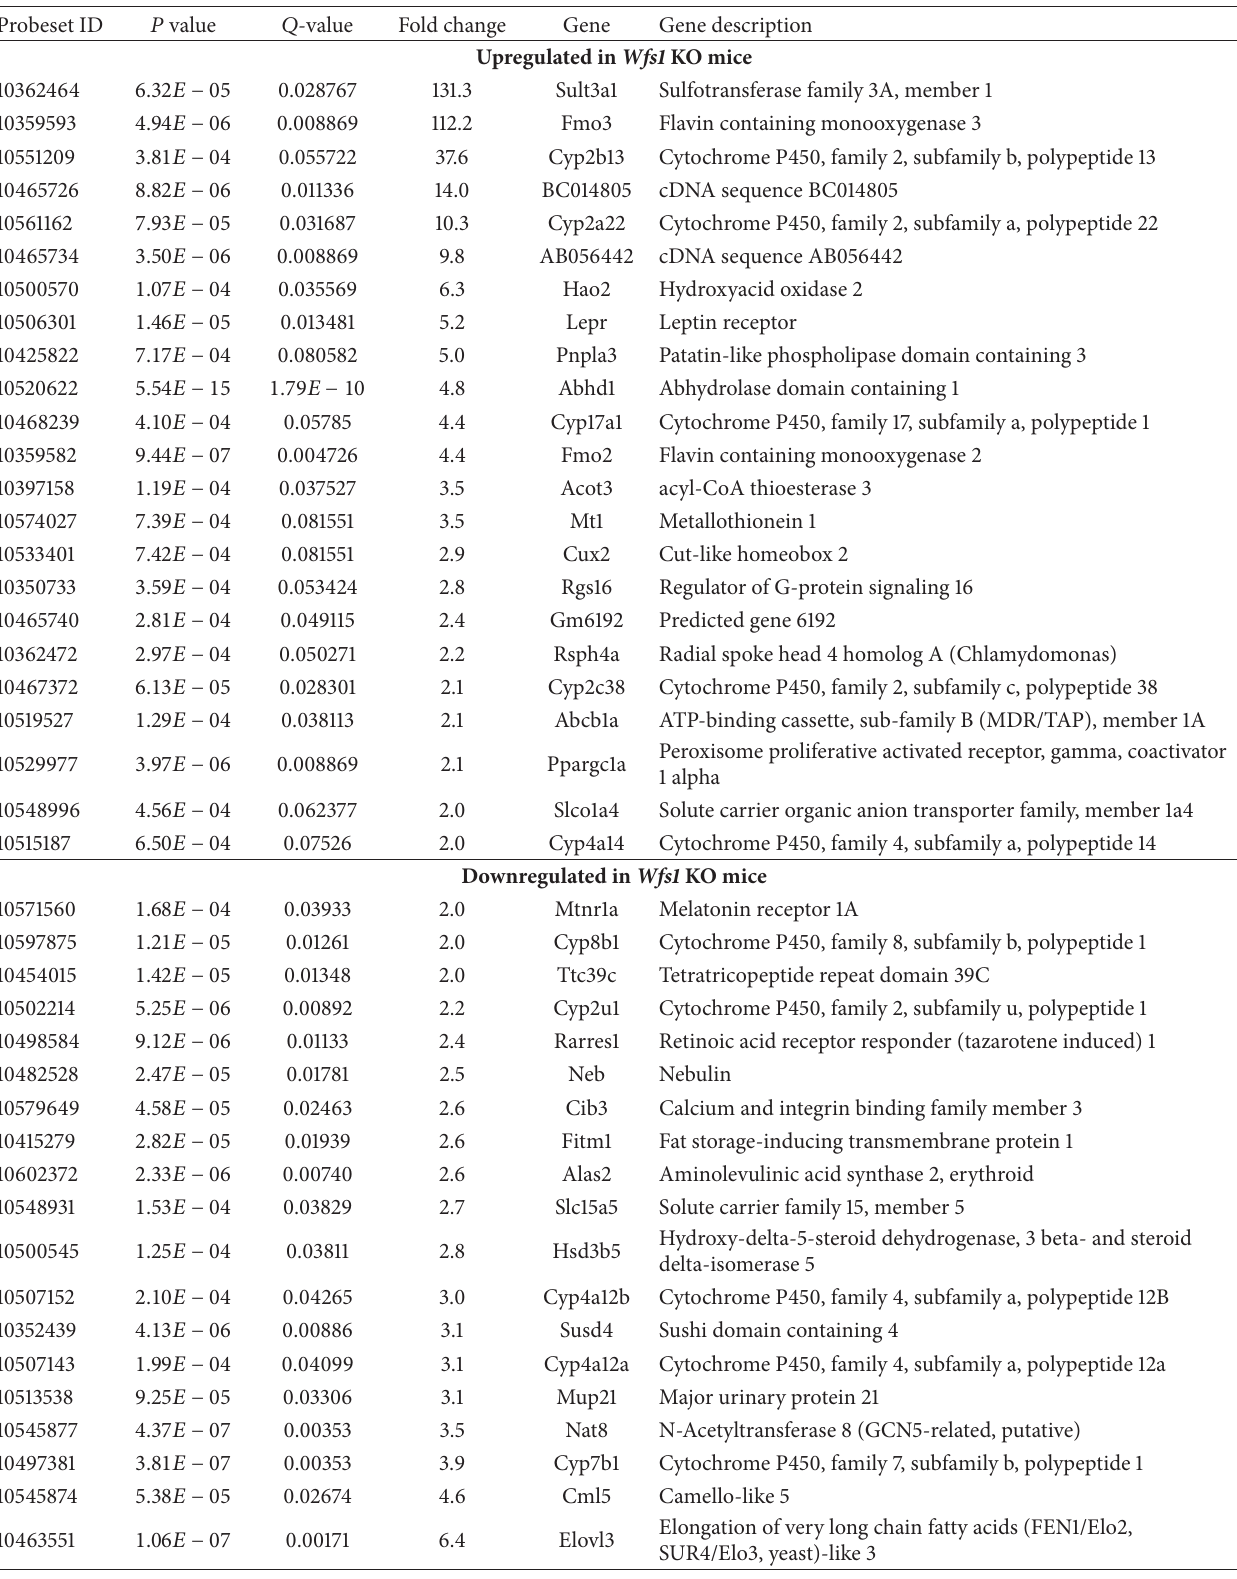
Table 1: List of genes whose expression in mouse liver is regulated by Wfs1 genotype as measured by Affymetrix GeneChip Mouse Gene 1.0 ST